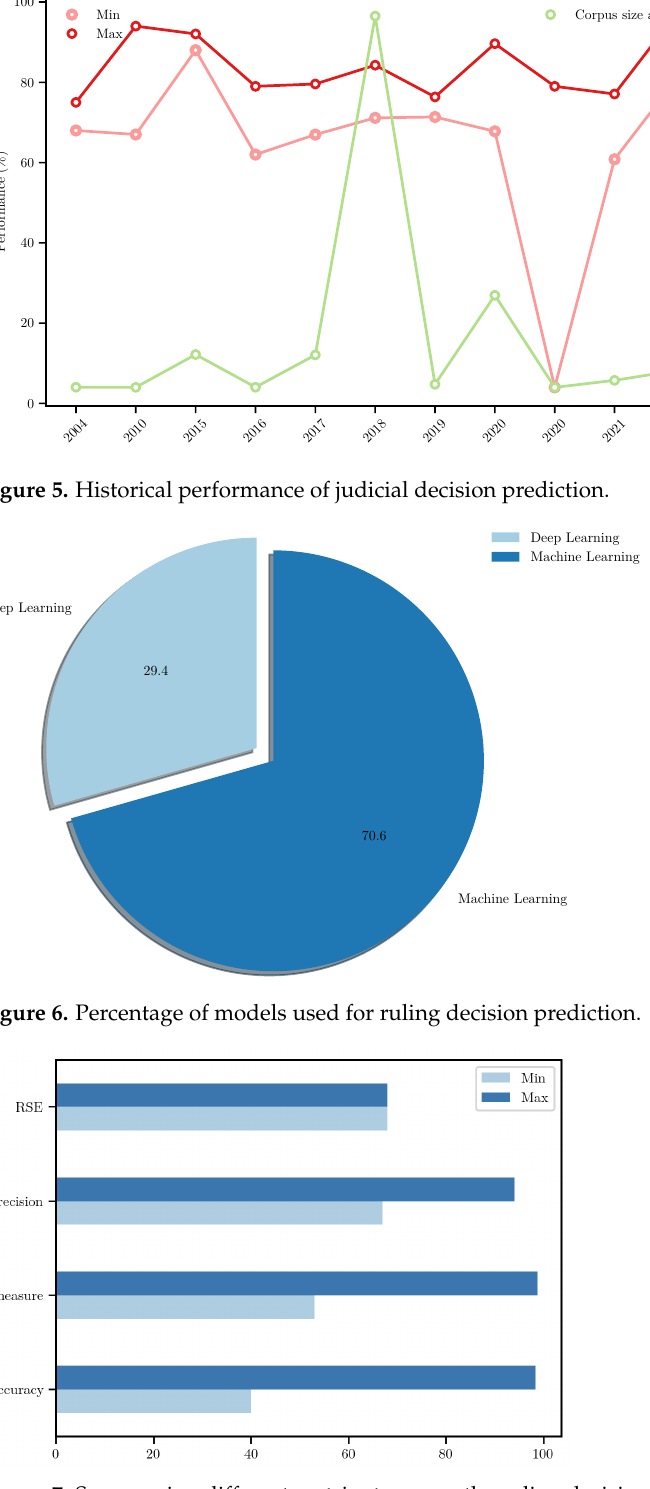
Figure 7. Scores using different metrics to assess the ruling decision